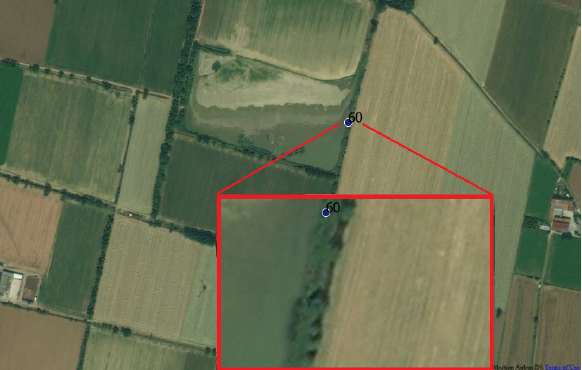
Figure 6. Example of an error in the LUCAS